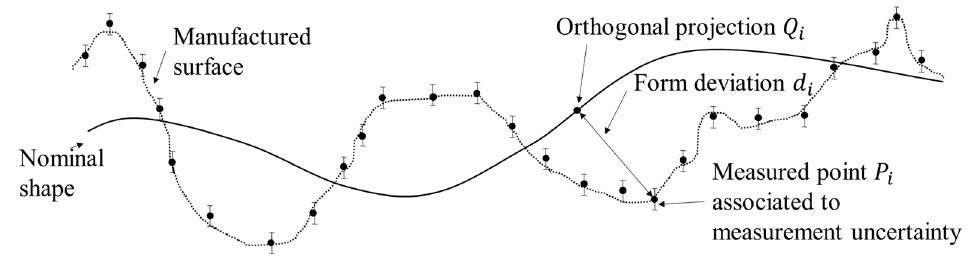
Figure 1. Definition of the form errors (or deviation errors).